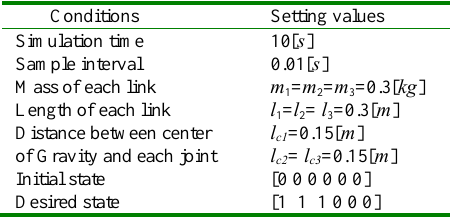
Tab.1 Setting parameters of simulations